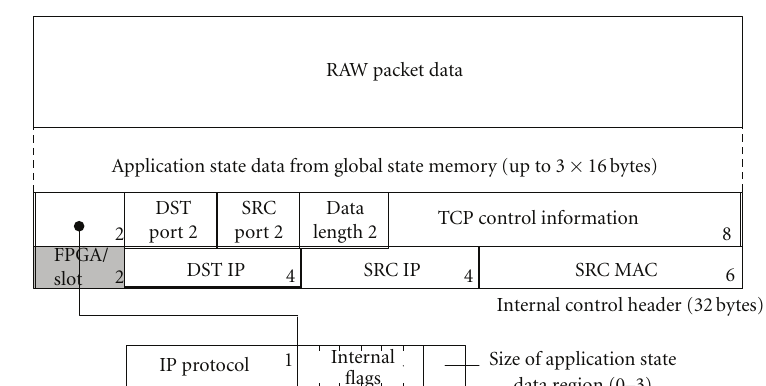
Figure 7: Master node architecture.